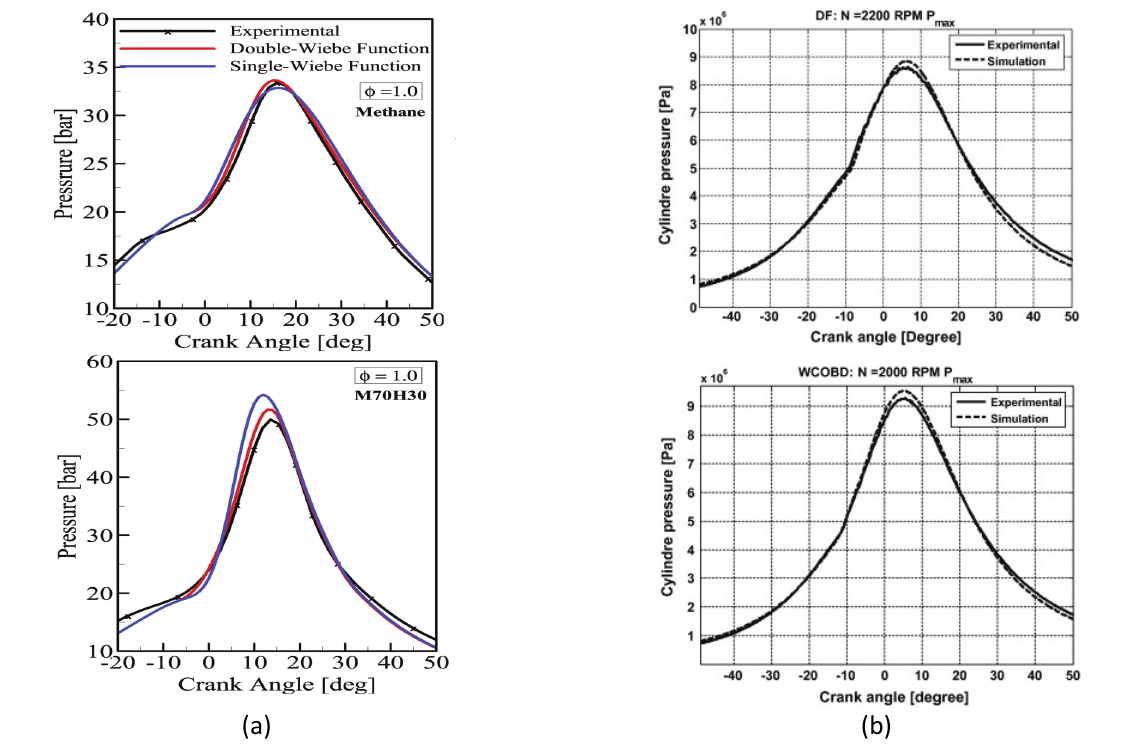
Fig. 4. Comparison of pressure development in single zone model (a) [32] and (b) [2]